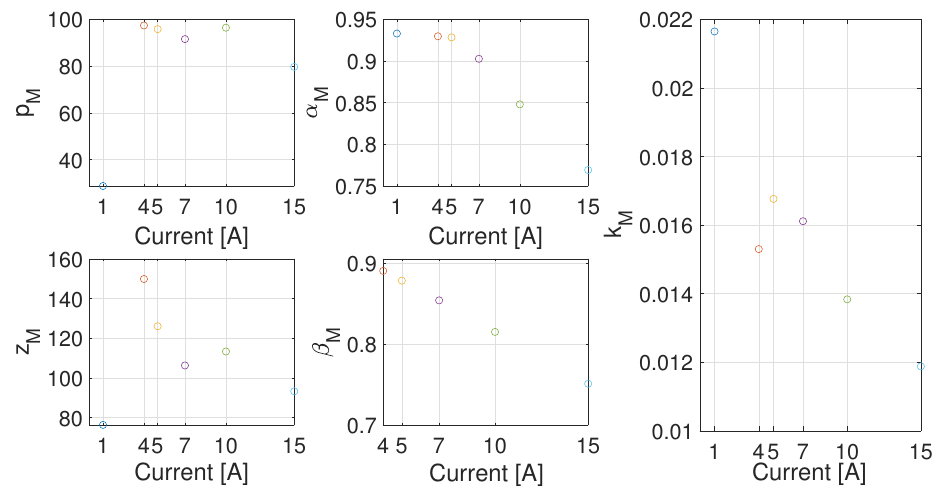
Figure 17. Parameters plot for each working point.